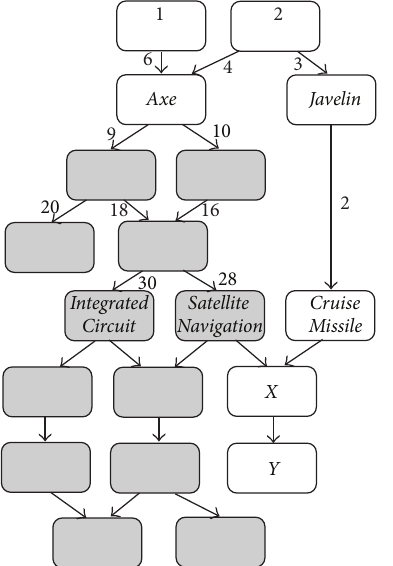
Figure 1: A problematic technology tree. Rounded rectangles depict technologies. They are of Boolean nature: either one possesses a technology, or not. The dependencies (marked with arrows) are of type OR. The numbers indicate costs in gold nuggets for advancing in the tech tree along the arrows. The costs for obtaining entrance nodes (ENs, the nodes representing the technologies that are initially available for development) are marked inside the corresponding